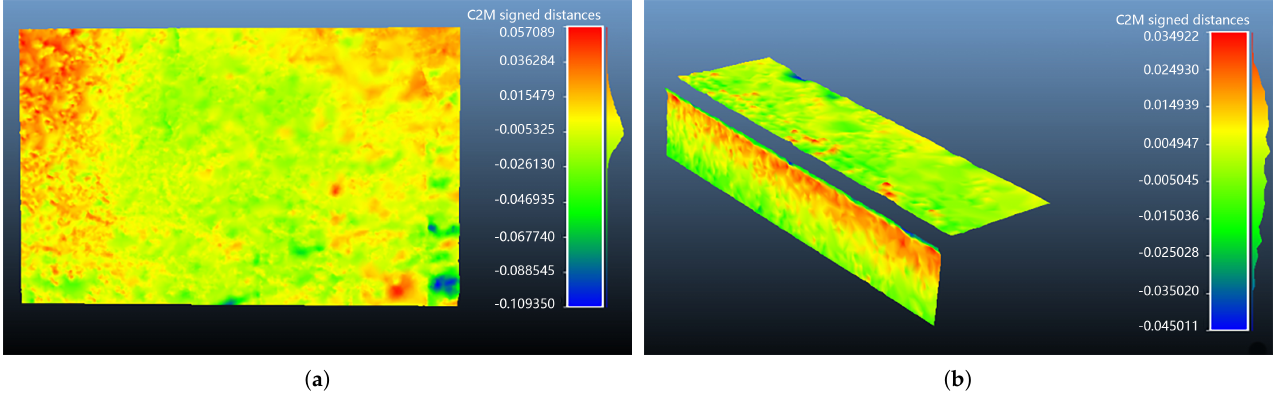
Figure 8. Heatmap of the planes in the reconstructed staircase. ( a ) A wall surface; ( b ) A step. To further evaluate the precision of the reconstructed model, we selected an “edge pair”, (i.e., an edge in a model matched with an edge in the actual scene), calculated a factor, and scaled the whole model. We selected some edge pairs, measured the edge length in